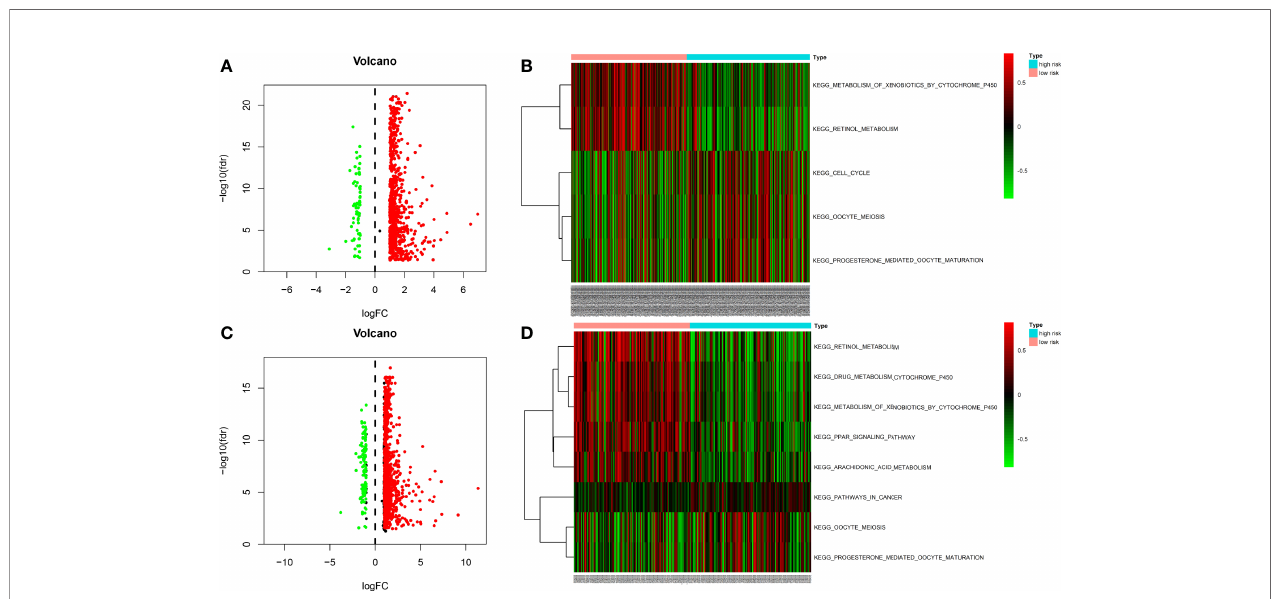
FIGURE 6 | Gene Set Variation Analysis between high- and low risk groups in the TCGA and ICGC cohort (A) Differentially expressed genes (DEGs) between high- and low-risk groups in the TCGA cohort (B) Gene Set Variation Analysis between high- and low risk groups in the TCGA cohort (C) Differentially expressed genes (DEGs) between high- and low-risk groups in the ICGC cohort (D) Gene Set Variation Analysis between high- and low risk groups in the ICGC cohort.